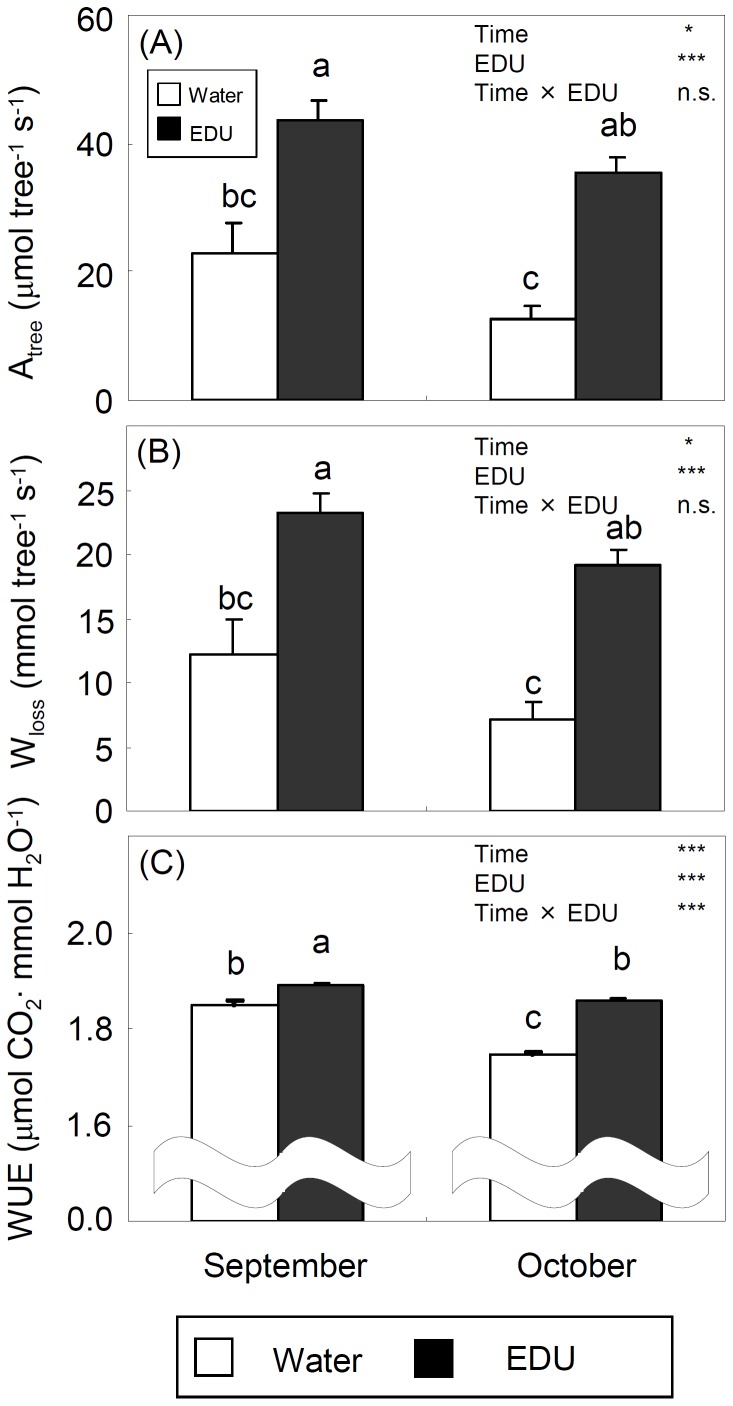
Estimated steady-state carbon assimilation (A: Atree), water loss (B: Wloss) and instantaneous water use efficiency expressed as Atree/Wloss (C: WUE) at tree level (+SE) (WAT: water treated plants; EDU: EDU treated plants).* and *** denote significance at the 5% and 0.1% level, respectively; n.s. indicates no significance. Different letters above the bars indicate significant differences among bars (Tukey HSD test, P<0.05, n = 5 trees).